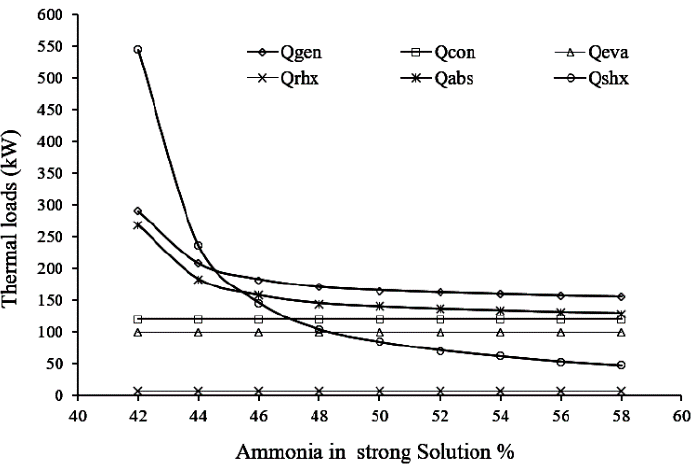
Figure 6. Variations of thermal loads with X ss .